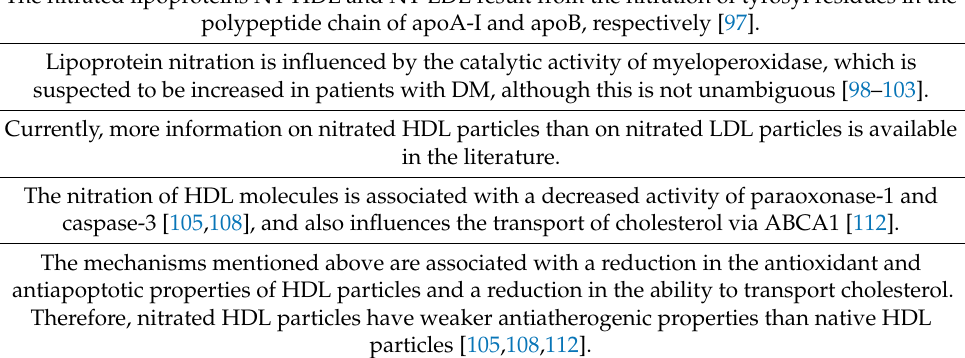
Table 3. Nitrated lipoproteins, diabetes mellitus, and cardiovascular disease—the most impor- tant